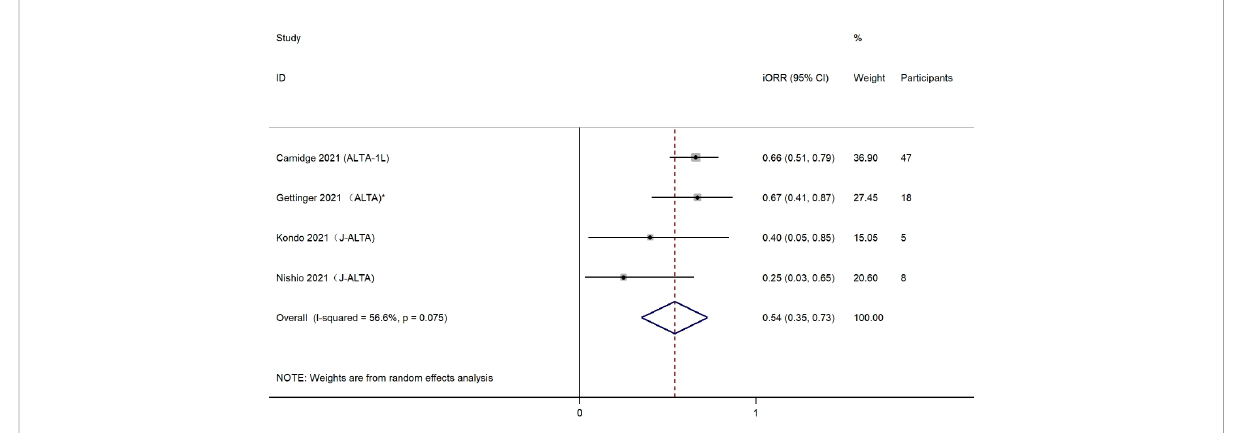
FIGURE 4 Forest plot of intracranial objective response rate (iORR).